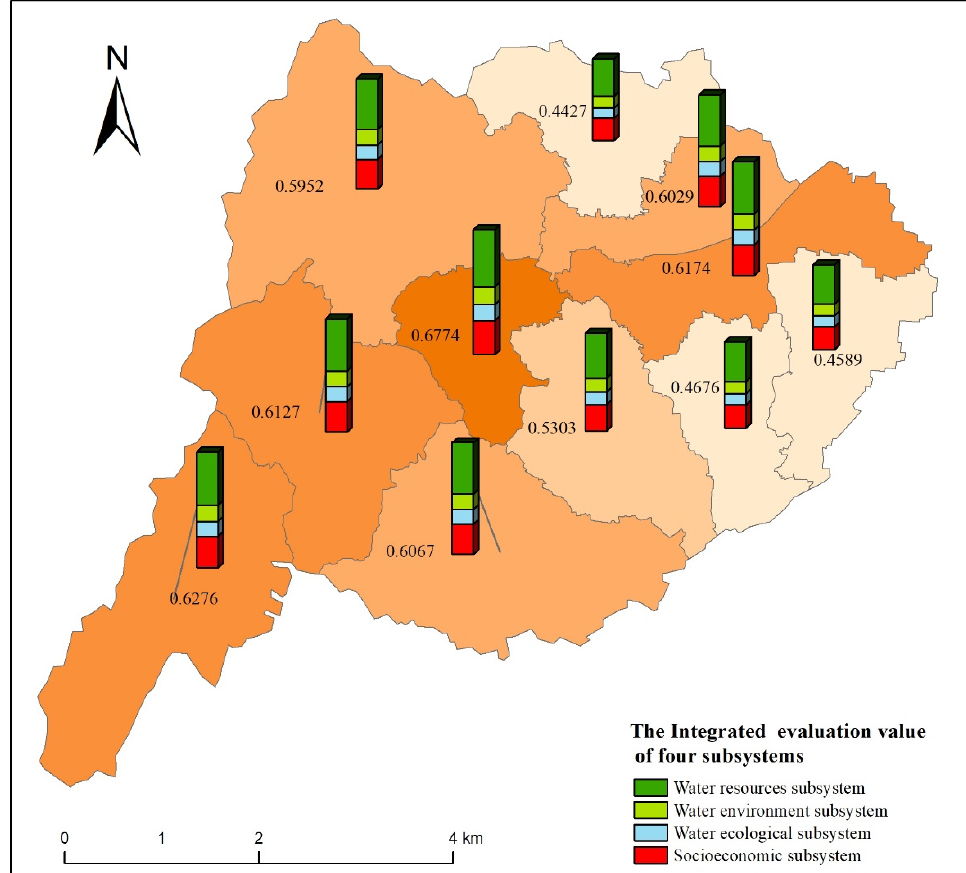
Figure 3. Comprehensive scoring values and accumulation of water resources carrying capacity in Zanhuang County. Zanhuang